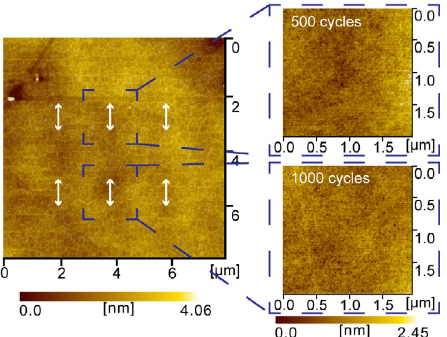
Fig. 9 Typical AFM surface topographical images after performing wear tests on the polished pure iron surface against a SiO 2 microsphere tip in